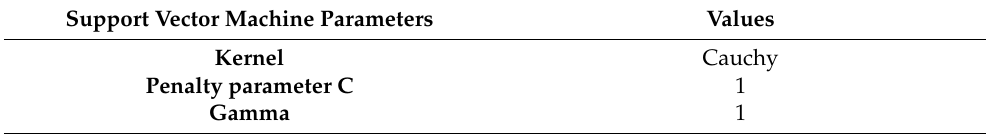
Figure A2. Support vector machine schematic showing the maximal hyperplane design to predict the best hyperplane to perform the regression. Table A2. Final optimized hyperparameters for support vector machine ensemble modelling. Table A2. Final optimized hyperparameters for support vector machine ensemble